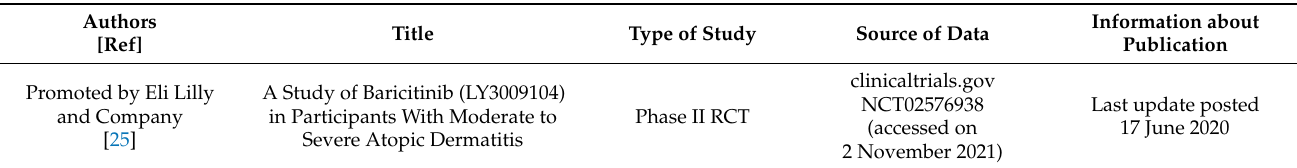
Table 2. Summary of sources